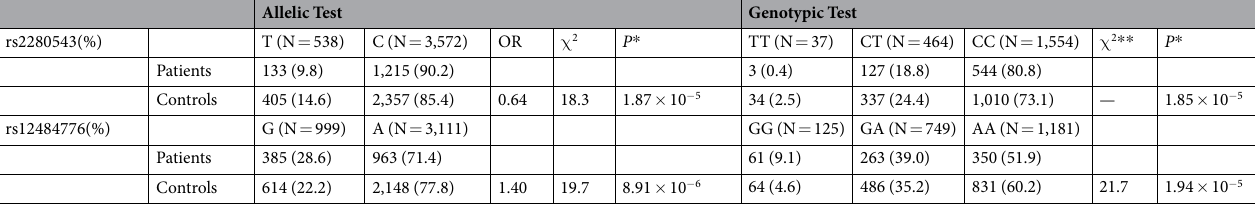
Table 2. Genetic association of rs2280543 and rs12484776 with UL. * P value threshold after Bonferroni